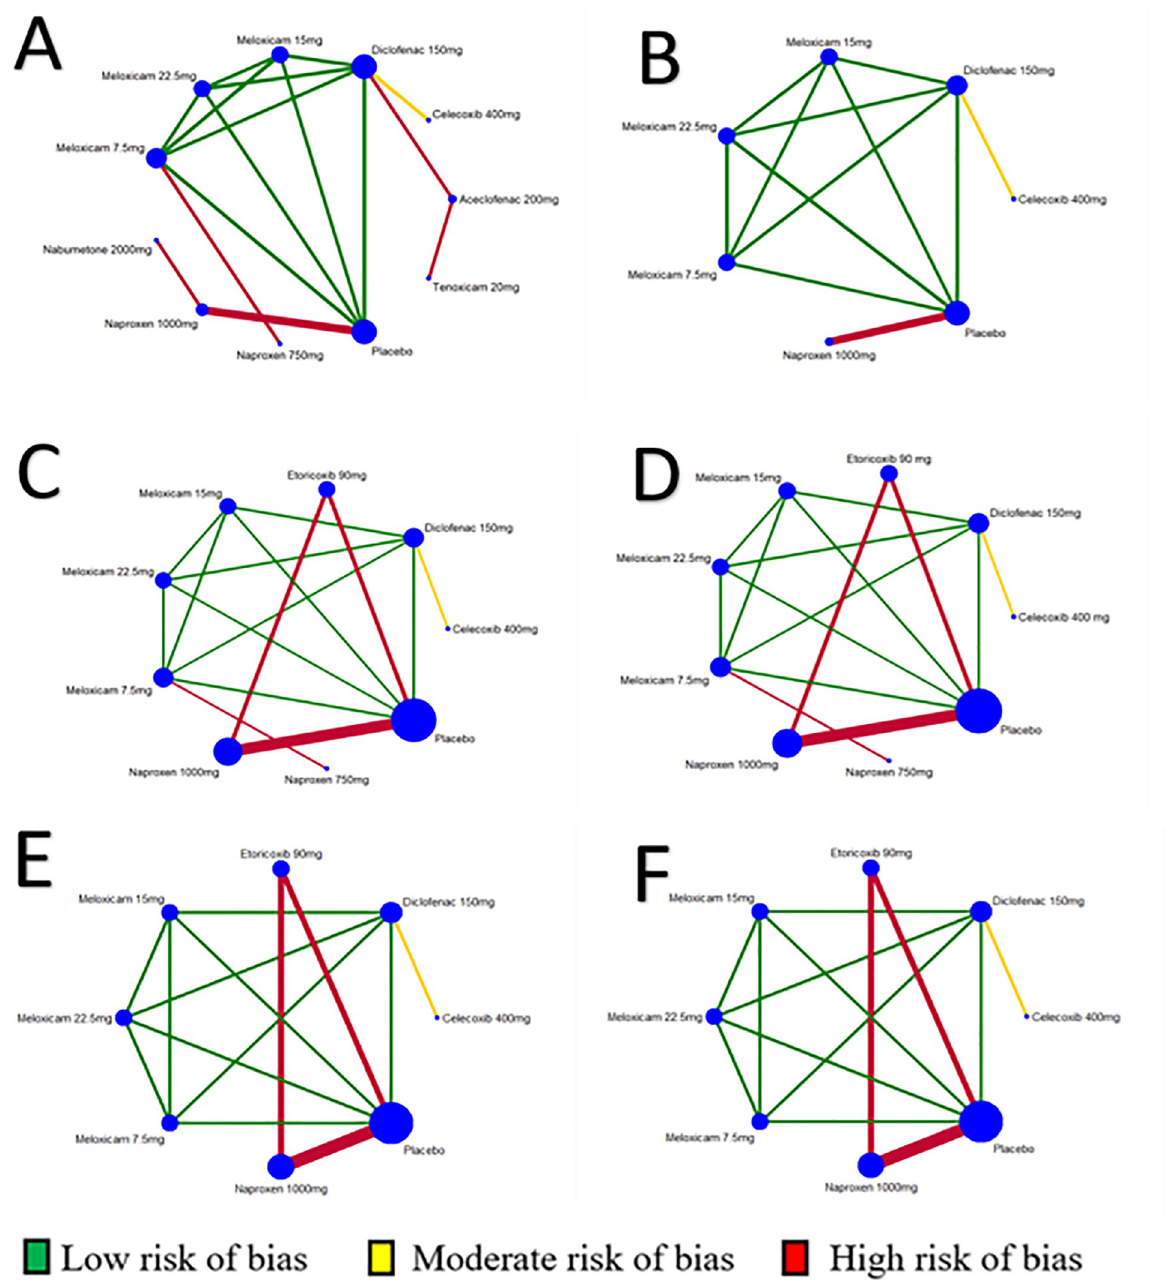
Fig 3. Evidence structure of eligible comparisons for network meta-analysis: Effectiveness outcomes. A—Pain (9 studies, 10 non-steroidal anti-inflammatories—NSAIDs, 22 arms, 4,016 patients); B—Physical function (4 studies, 5 NSAIDs, 11 arms, 2,447 patients); C- Number of tender/painful joints (8 studies, 6 NSAIDs, 21 arms, 4,962 patients); D—Number of swollen joints (8 studies, 6 NSAIDs, 21 arms, 4,962 patients); E—Patient’s Global Assessment (6 studies, 6 NSAIDs, 17 arms, 4,152 patients); F—Physician’s Global Assessment (6 studies, 6 NSAIDs, 17 arms, 4,152